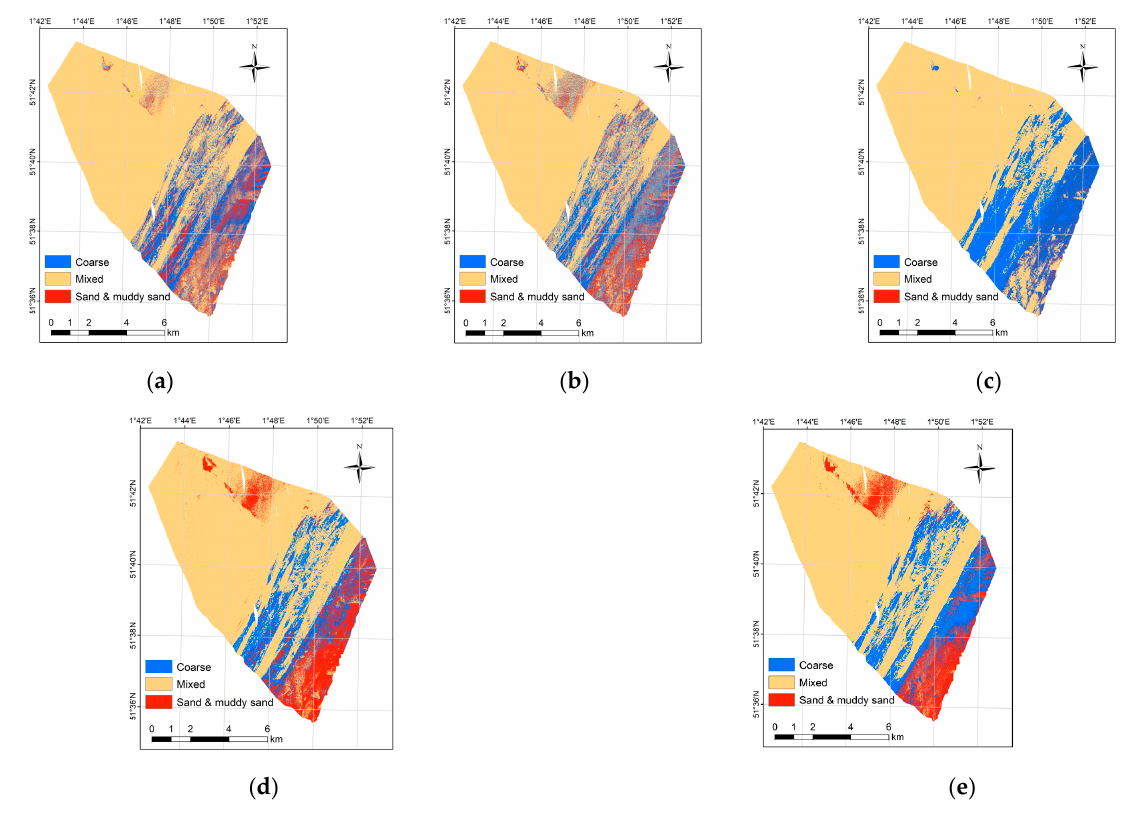
Figure 11. Seabed sediment classification maps of different classifiers for S1. ( a ) RF = random forest; ( b ) KNN = K-nearest neighbor; ( c ) SVM = support vector machine; ( d ) RPNet = random patches network; ( e ) DBN = deep belief network.